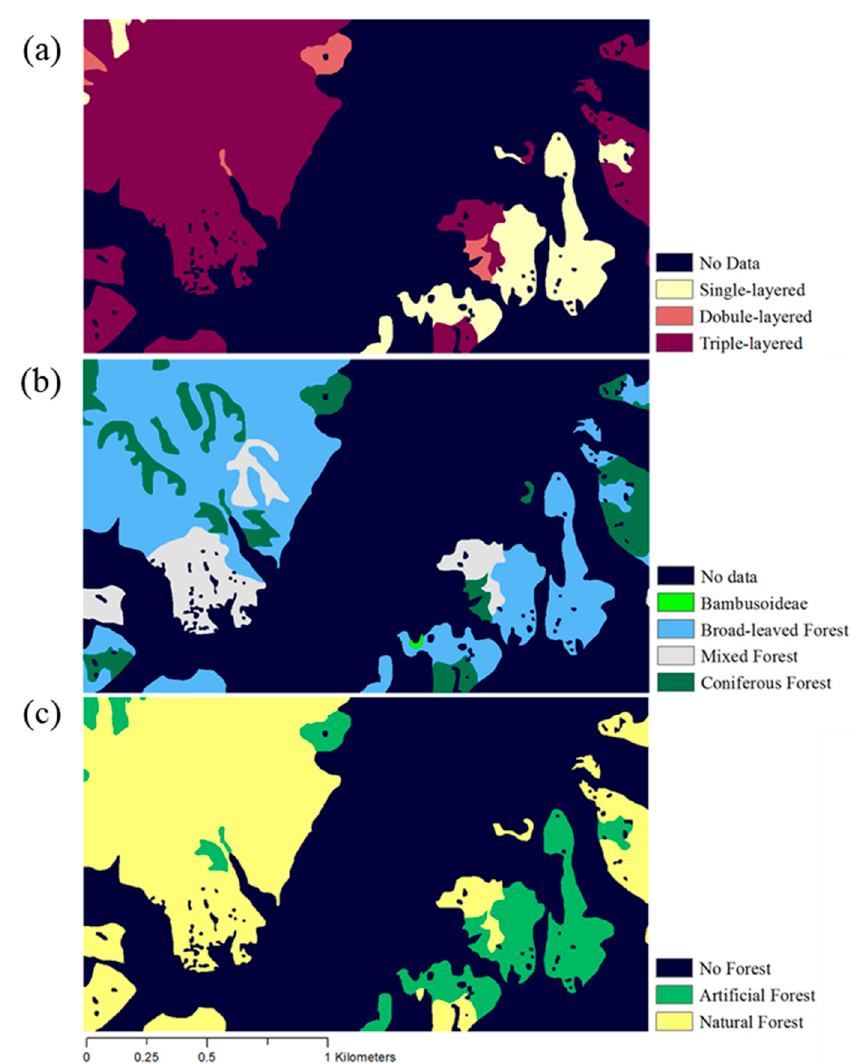
Figure 2. Forest classification maps of the study area produced from the field survey. ( a ) Forest vertical structure; ( b ) dominant species’ leaf type; ( c ) natural and artificial forests.